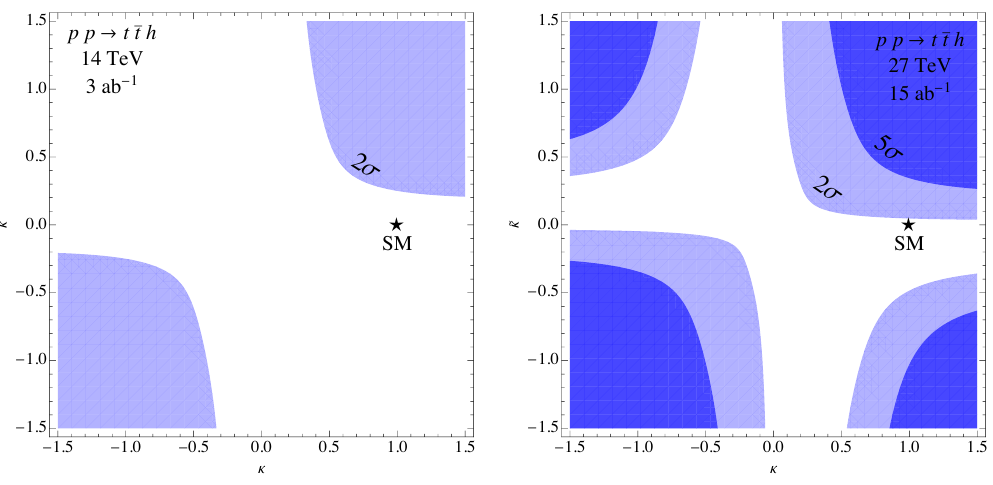
Figure 9 . The HL-LHC (3 ab (cid:0) 1 ) and HE-LHC (15 ab (cid:0) 1 ) exclusion regions in the case of measuring a 2 (cid:27) positive (cid:13)uctuation in O 6 (3.8) (see text for details). shown in (cid:12)gure 8 for di(cid:11)erent integrated luminosities at 14 TeV (left panel) and 27 TeV (right panel). These results show that the HL-LHC is somewhat limited by statistics while the HE-LHC gives a promising coverage of parameter space, in particular it is sensitive to CP -odd couplings of order O (0 : 1) at high luminosities. In (cid:12)gure 8 we provide the 2 (cid:27) and 5 (cid:27) exclusion regions of the HE-LHC at 15 ab (cid:0) 1 . Since the observable O behaves as / (cid:20) ~ (cid:20)= ( (cid:20) 2 + d ~ (cid:20) 2 ) for some constant d , the value of O